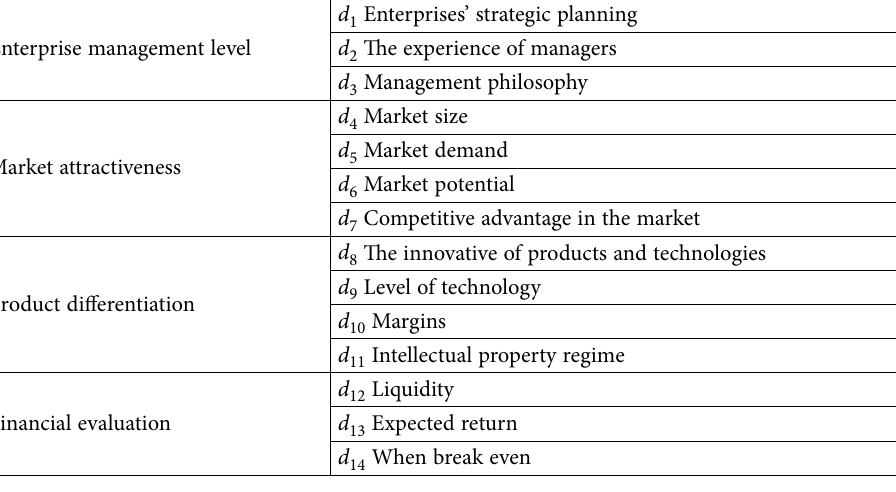
Table 2. The income criteria